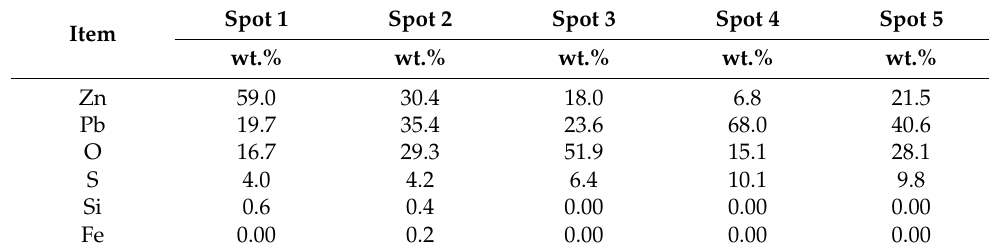
Table 5. The EDS analysis results of the selected area of atmospheric leaching residue in Figure 11. Spot 1 Spot 2 Item